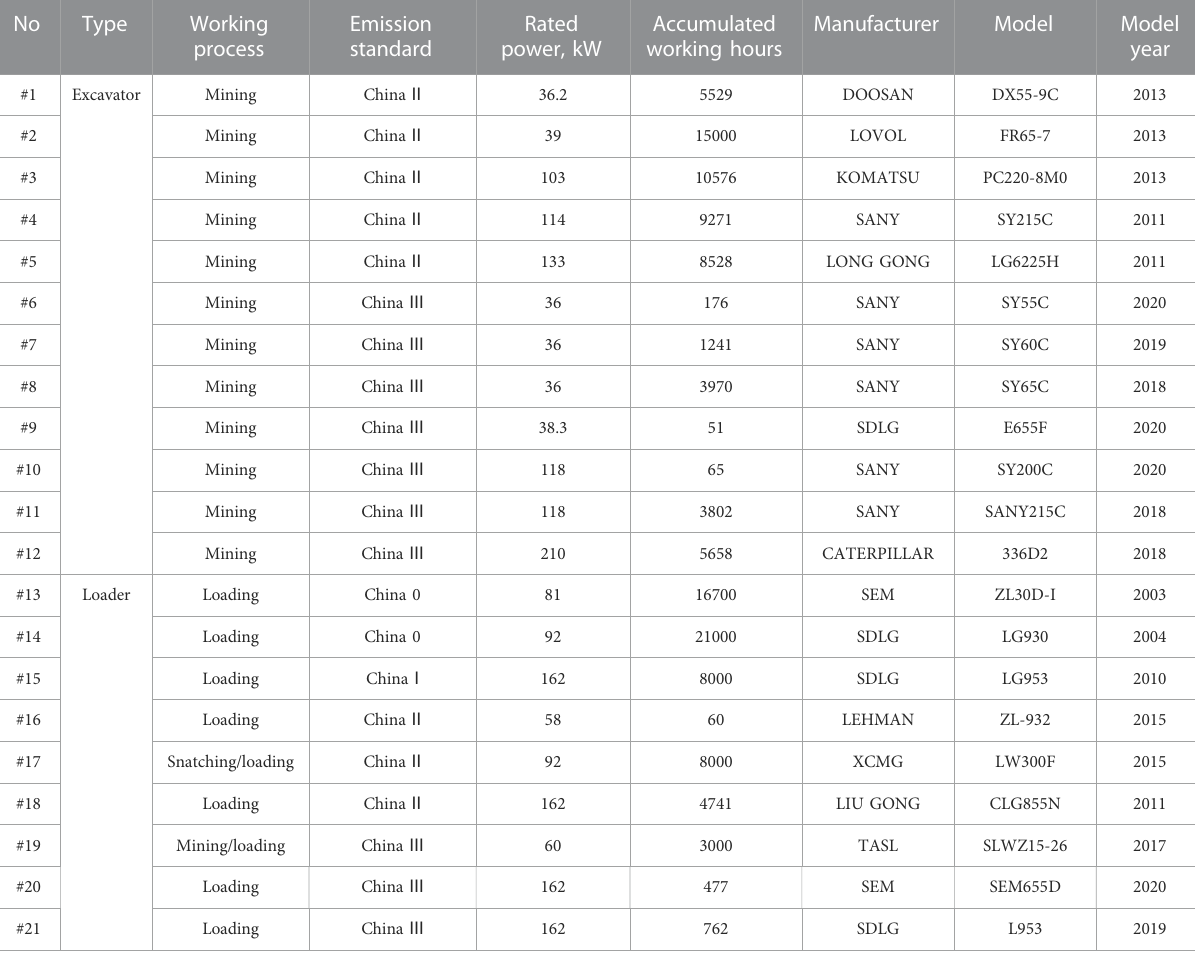
TABLE 1 Detailed information on the construction machineries tested in this